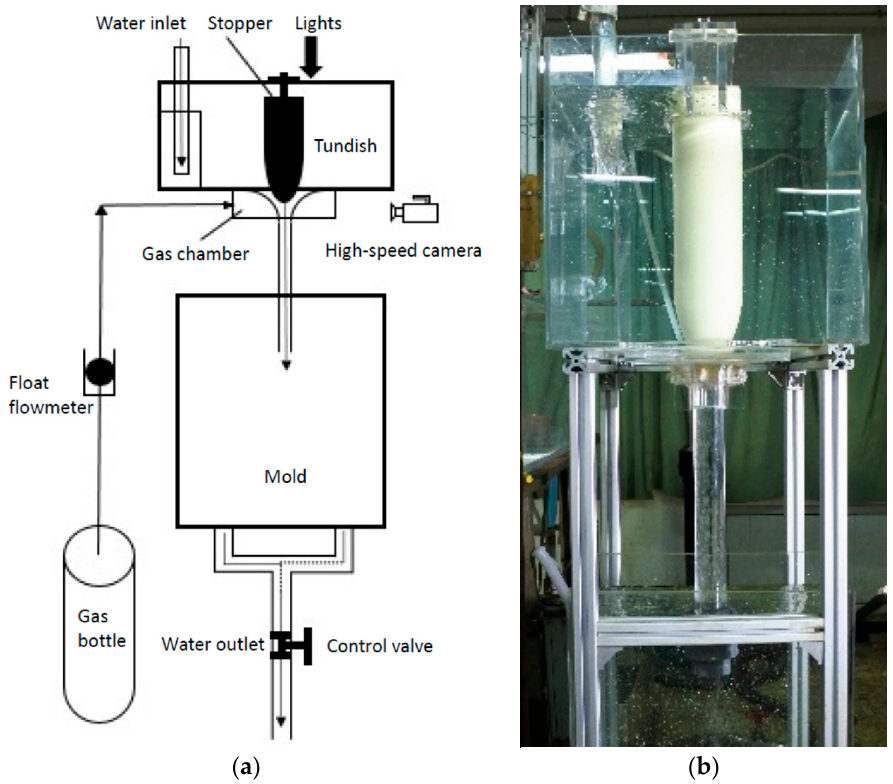
Figure 3. Experimental device of the water model: ( a ) schematic diagram of the experimental device; ( b ) photo of the experimental device.